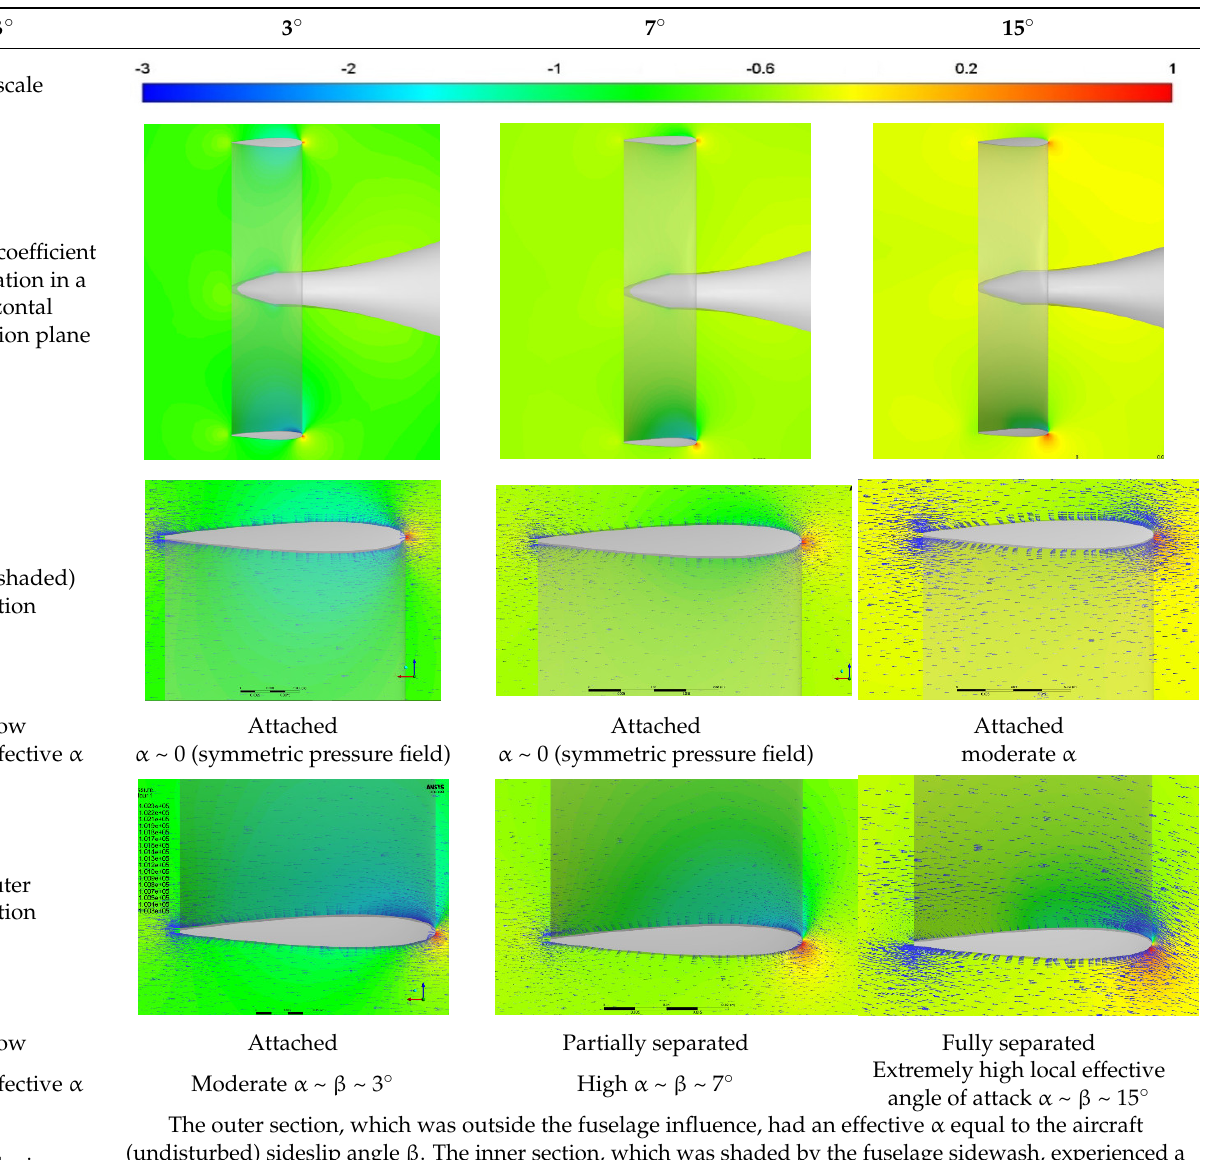
Figure 23. Velocity streamlines at a high sideslip β ~ 15° revealing the impact of the fuselage side- wash on the tail duct inner (shaded) side local effective angle of attack. Table 7. Pressure field of the tail duct in a horizontal section plane.